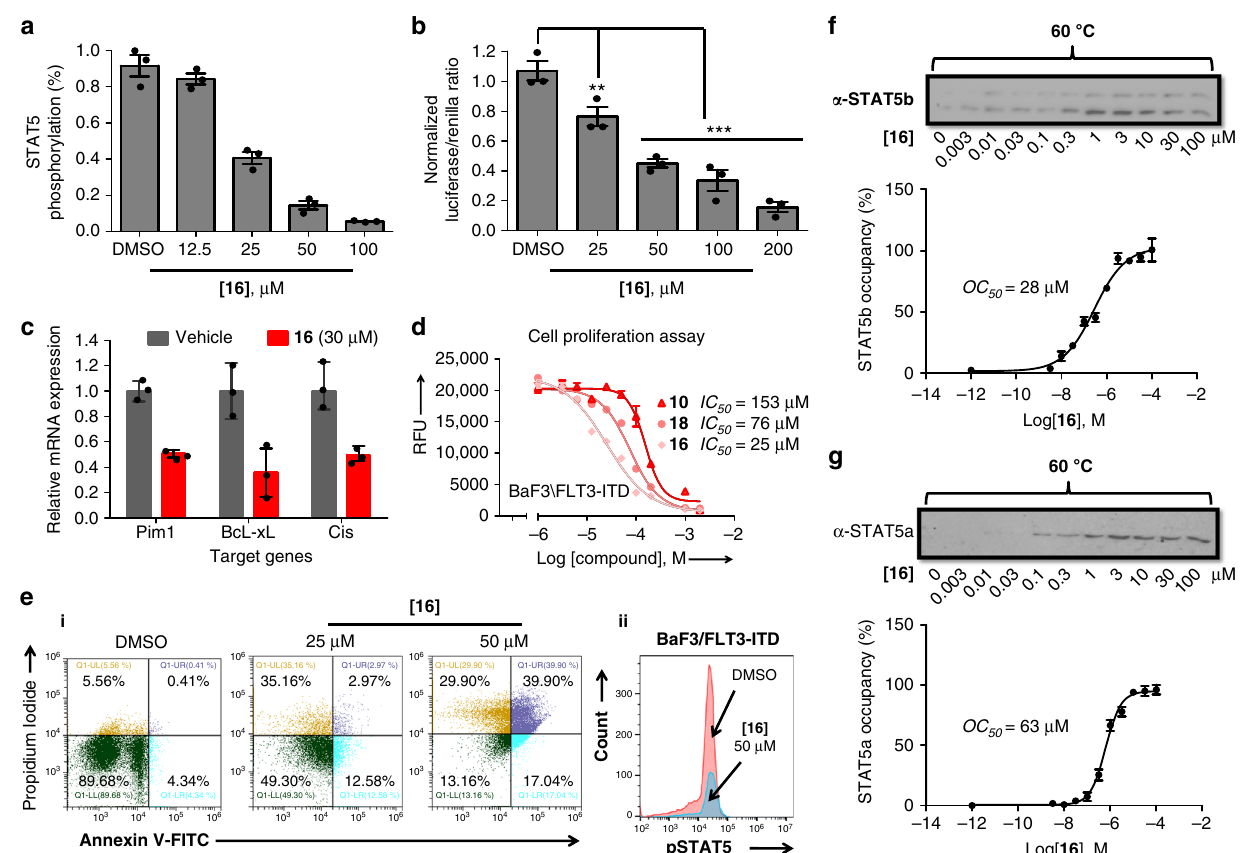
Fig. 5 Activity, target occupancy, and functional effects of STAT5 inhibitor 16 tested in STAT5-dependent cells. a 16 blocks tyrosine phosphorylation of STAT5 in a dose-dependent manner as shown by western blot analysis in BaF3/FLT3-ITD cells after 6 h treatment. Relative STAT5 phosphorylation levels were plotted as after quanti fi cation using Image J software. Immunoblotting for beta-actin was used as a control for uniform protein loading ( n = 3). b Compound 16 inhibits transcriptional activity of STAT5 in BaF3/FLT3-ITD cells as measured by normalized Fluc/Rluc ratio in dual luciferase